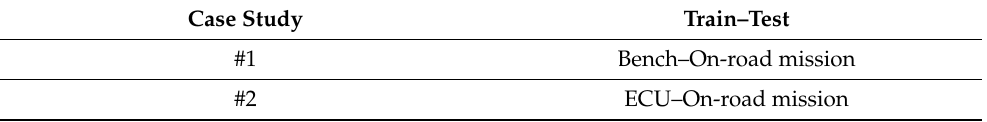
Table 3. Dynamic on-road case analysis based on training phase over different acquisition systems.